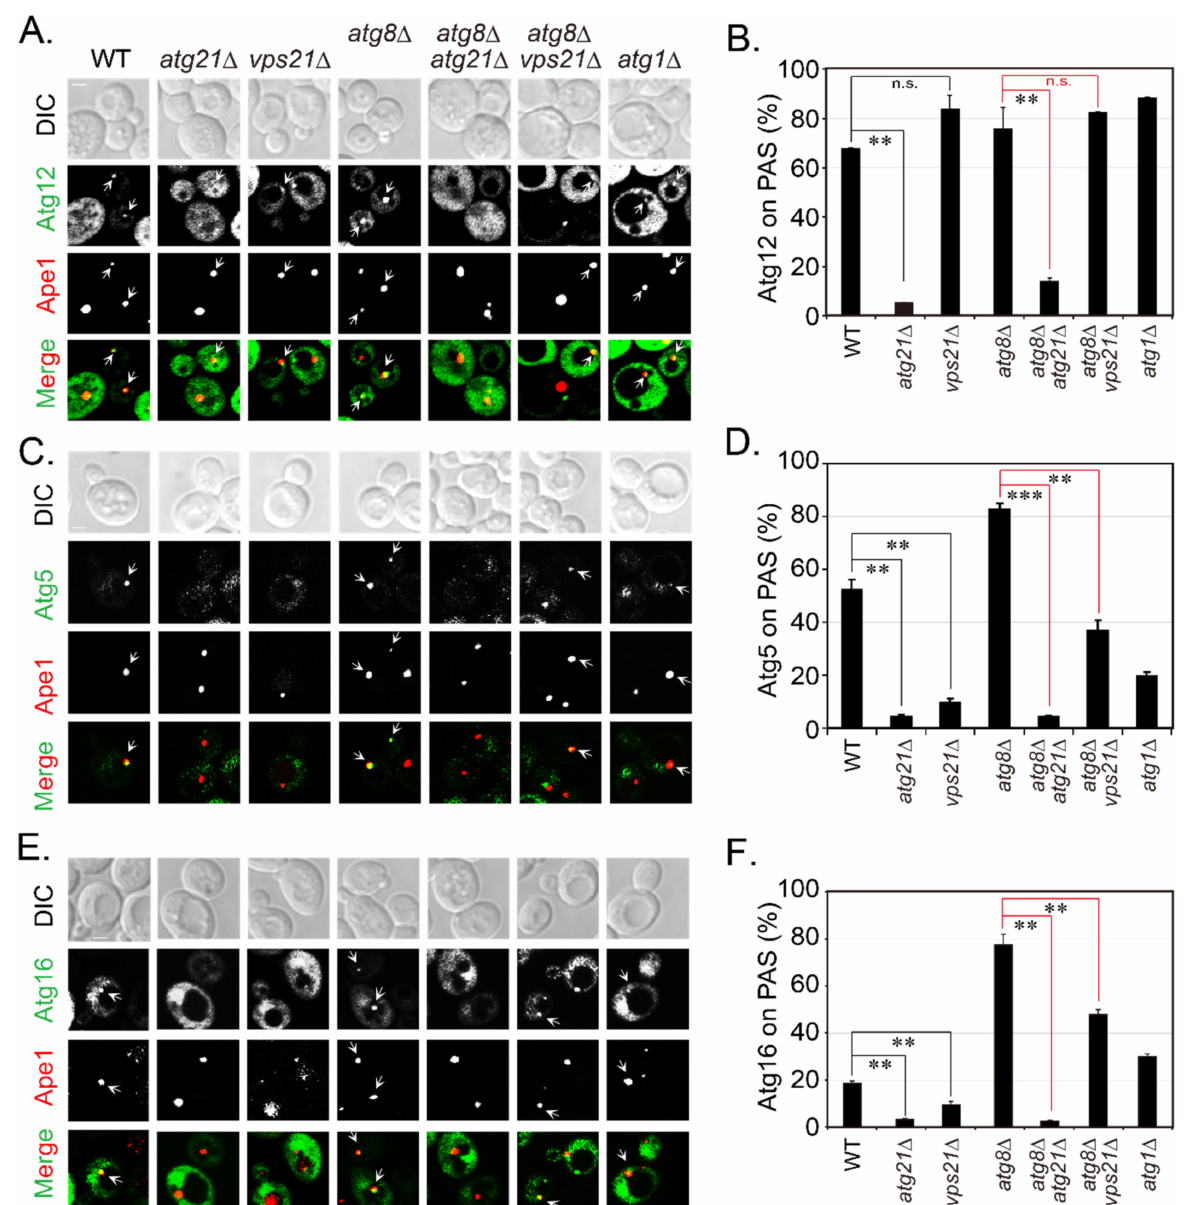
Figure 7. Localizations of Atg5 and Atg16 to RFP-Ape1-labeled PAS decrease in vps21 ∆ cells. The indicated strains were transformed with the pRS415- CUP1p -yEGFP-Atg12, pRS415- CUP1p -yEGFP- Atg16, and pRS415- CUP1p -Atg5-yEGFP plasmids. Cells were grown to mid-log phase, starved in SD-N medium for 2 h, and examined for fluorescence, as described in Figure 1D. ( A ) Atg12 localization to RFP-Ape1-labeled PAS/APs depended on Atg21 but not on Vps21. ( B ) Quantification of the data presented in panel ( A ). ( C ) Atg5 localization to RFP-Ape1-labeled PAS/APs depended on Atg21 and Vps21. ( D ) Quantification of the data presented in panel ( C ). ( E ) Atg16 localization to RFP-Ape1-labeled PAS/APs depended on Atg21 and Vps21. Scale bars, 5 µ m. ( F ) Quantification of the data presented in panel ( E ). Arrows in panels ( A , C , E ) indicate the colocalization between green Atg and red Ape1 dots. The percentages of colocalized RFP-Ape1-labeled PAS/AP dots shown in panels ( A , C , E ) were quantified and presented in panels ( B , D , F ), respectively, as the mean ± SD. n.s., not significant; **, p < 0.01; ***, p <